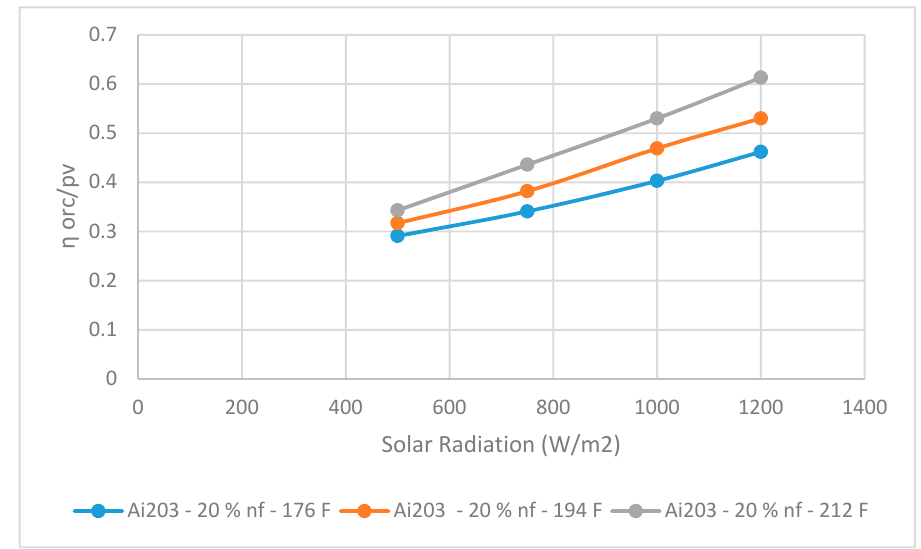
Figure 5. Hybrid system efficiency for Nanofluid CuO at different temperatures and 20% volumetric concentration.